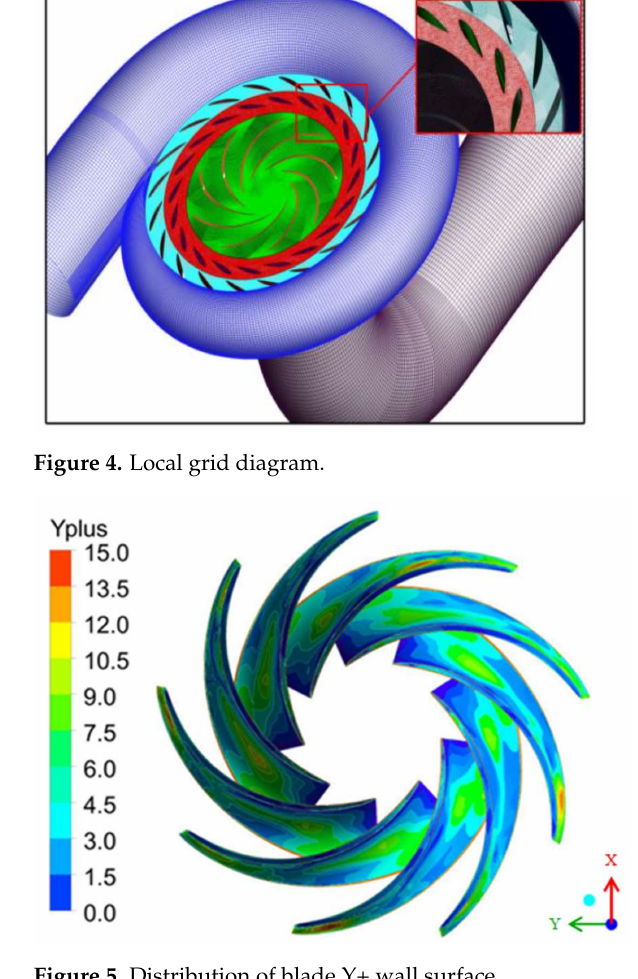
Figure 5. Distribution of blade Y+ wall